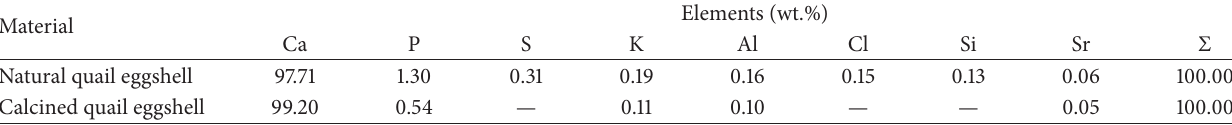
Table 1: Chemical composition (wt.%) of natural quail eggshell and calcined quail eggshell.